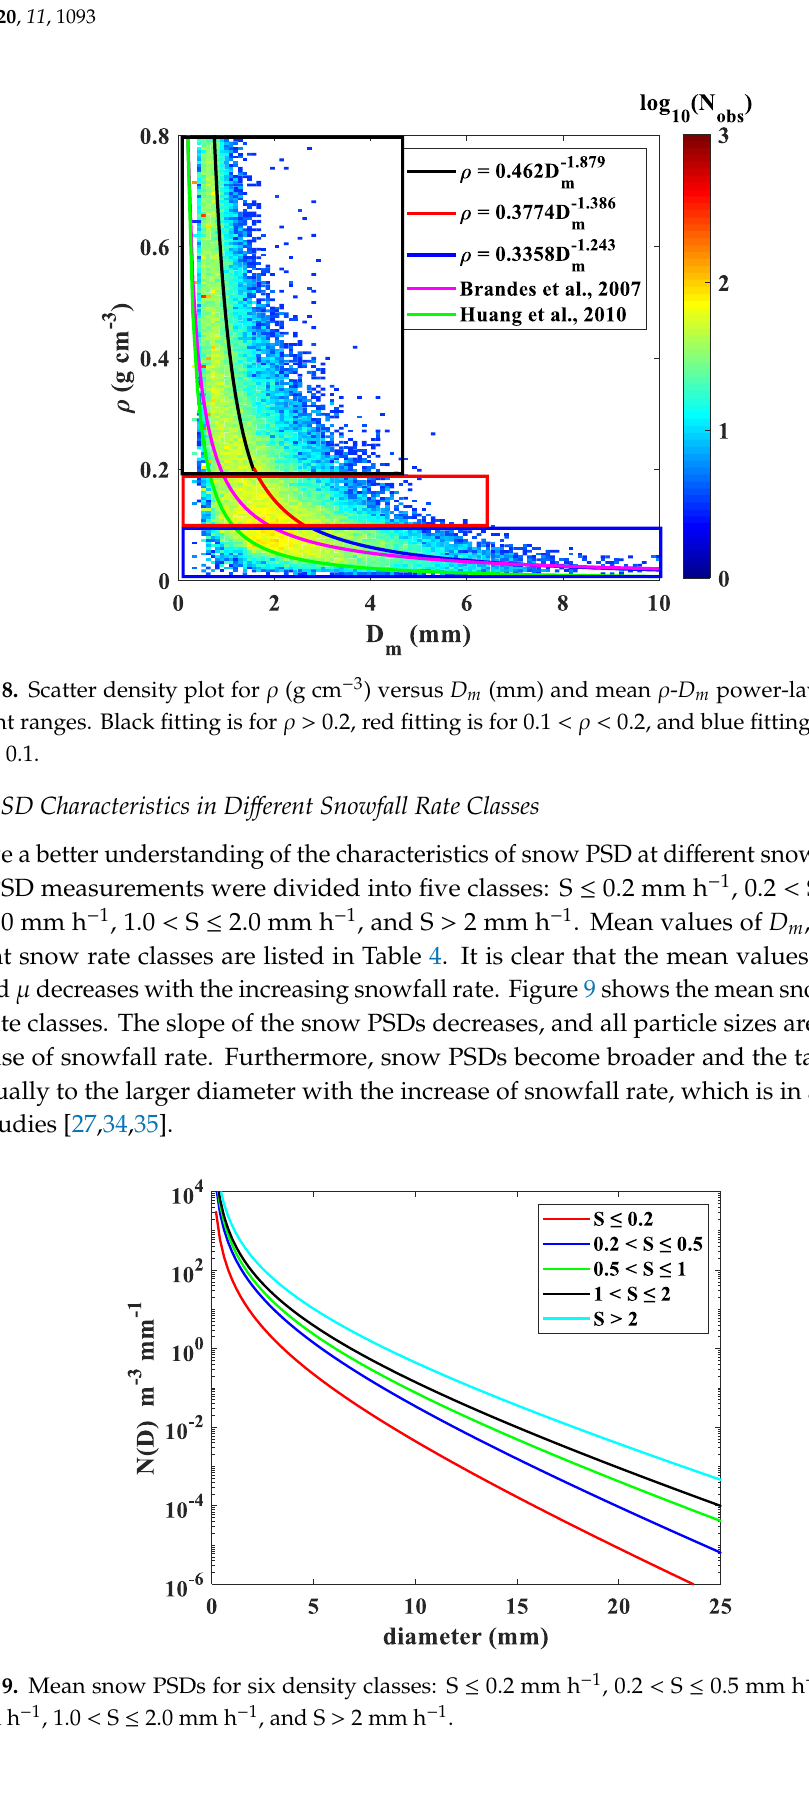
Figure 9. Mean snow PSDs for six density classes: S ≤ 0.2 mm h −1 , 0.2 < S ≤ 0.5 mm h −1 , 0.5 < S ≤ 1.0 mm h −1 , 1.0 < S ≤ 2.0 mm h −1 , and S > 2 mm h −1 .